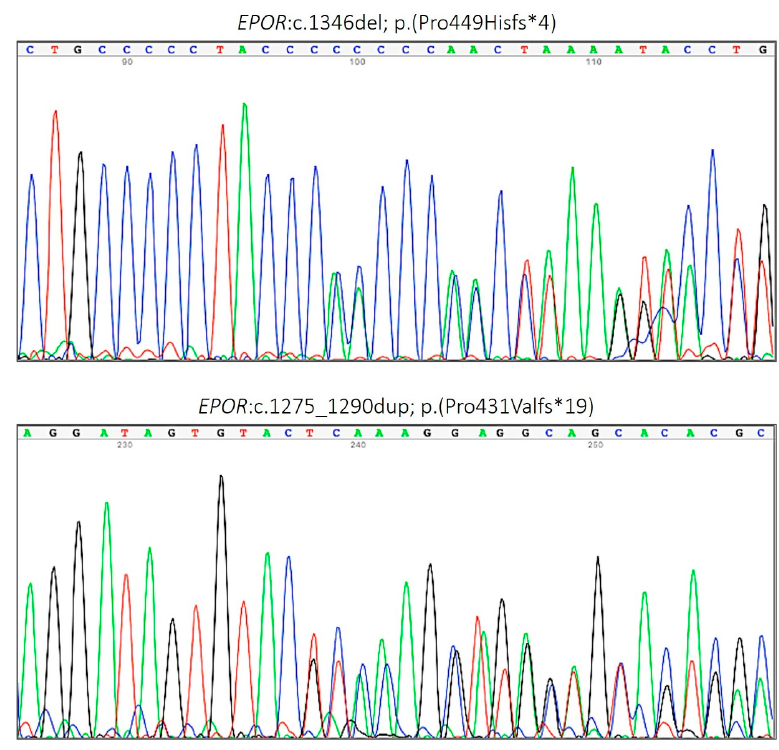
Figure 1. EPOR pathogenic variants identified in this study. Segregation studies were attainable in the brother of case 1 and in all three healthy children of case 2. The 32-year-old brother, who also had erythrocytosis and low EPO levels, resulted as a carrier of the same c.1275_1290dup variant. EPOR sequencing of case 2 ′ s healthy children revealed that his 18-year-old son was the only of the three inheriting the c.1346del variant. All 33 EPOR variants reported to be associated with PFCP to date, and their classifi- cation are listed in Table 1. According to ACMG/AMP guidelines, 26 of them are classified as pathogenic or likely pathogenic, 3 are variants of uncertain significance, and 4 are be- nign or likely benign. Table 1. PFCP-associated EPOR variants reported to date. Exon